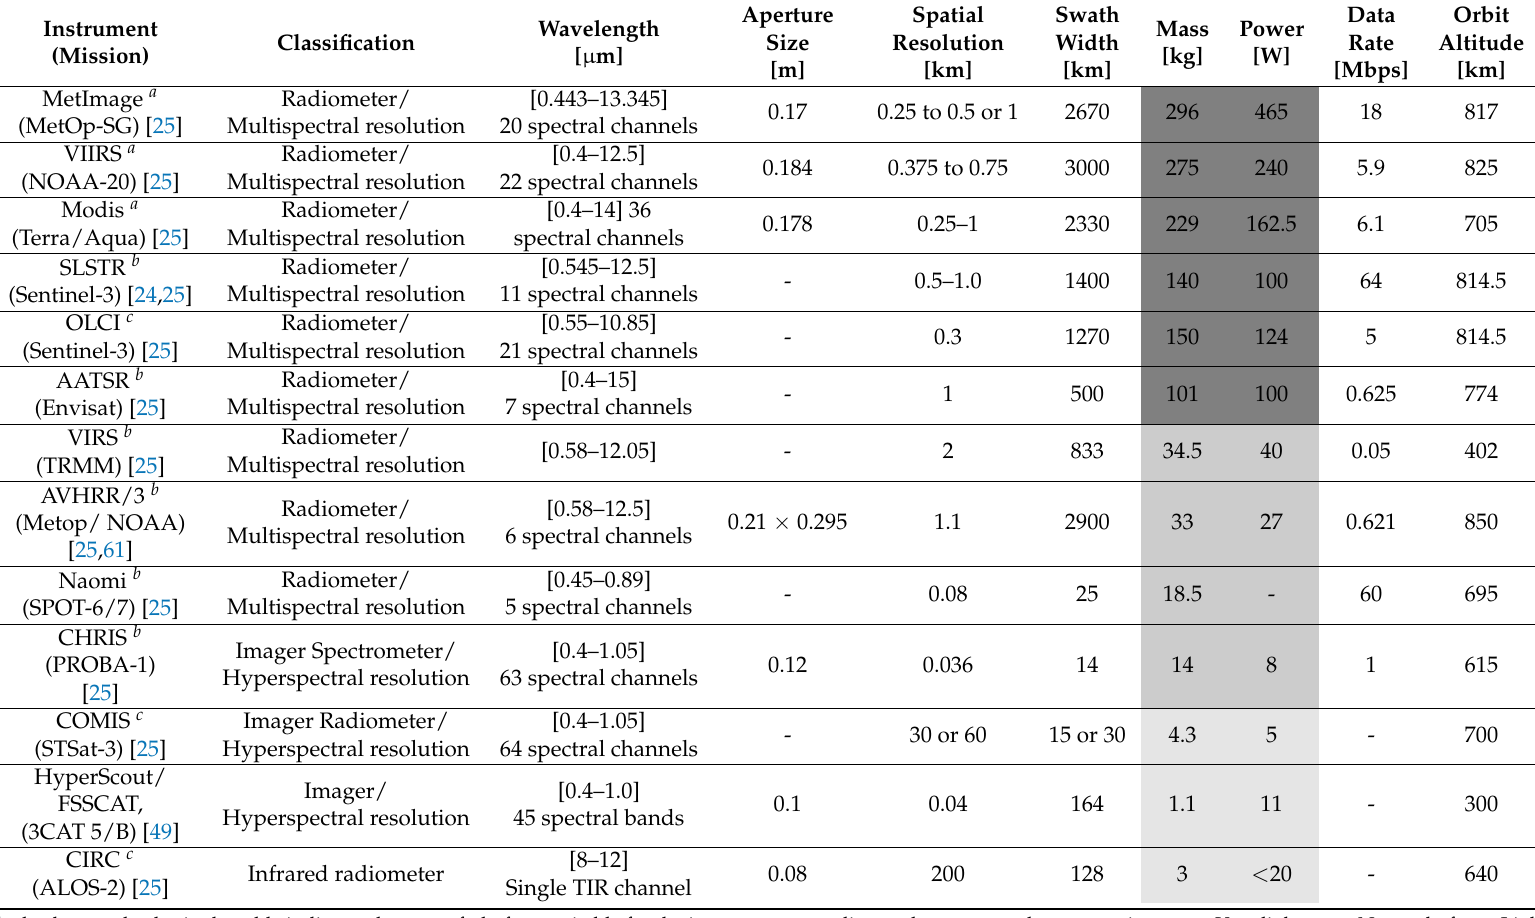
The background color in the table indicates the type of platform suitable for the instrument according to the power and mass requirements: Very light gray: Nano-platform; Light gray: Micro-platform; gray: mini-platform; a Instrument affordable for a wide range of geophysical variables, from cloud classification and properties, to aerosol main